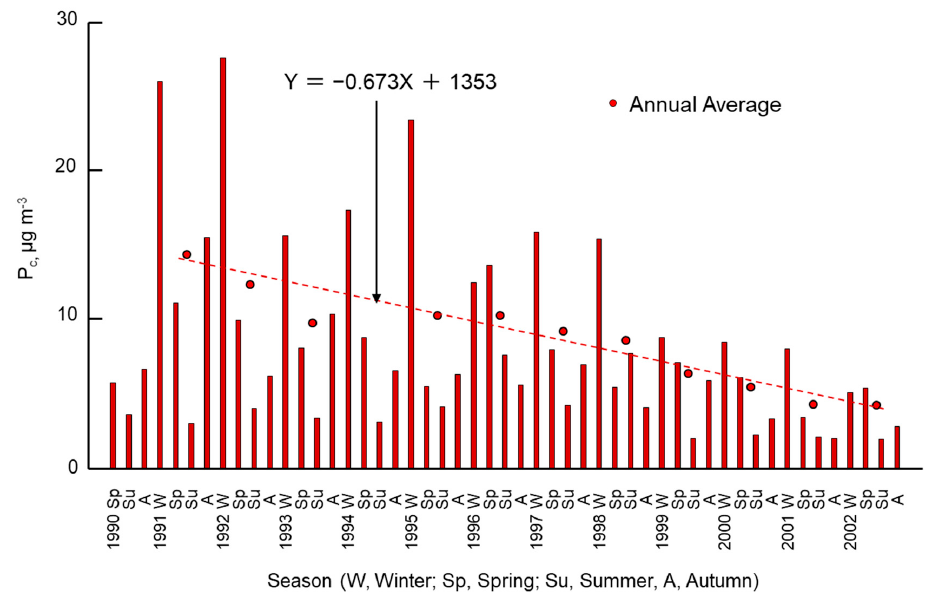
Figure 2. Atmospheric concentration of P c in Sapporo from 1990 to 2002 by season. Table 2. Seasonal atmospheric concentrations of TSP, P c , and P n concentrations as well as P c /TSP ratio in Sapporo.